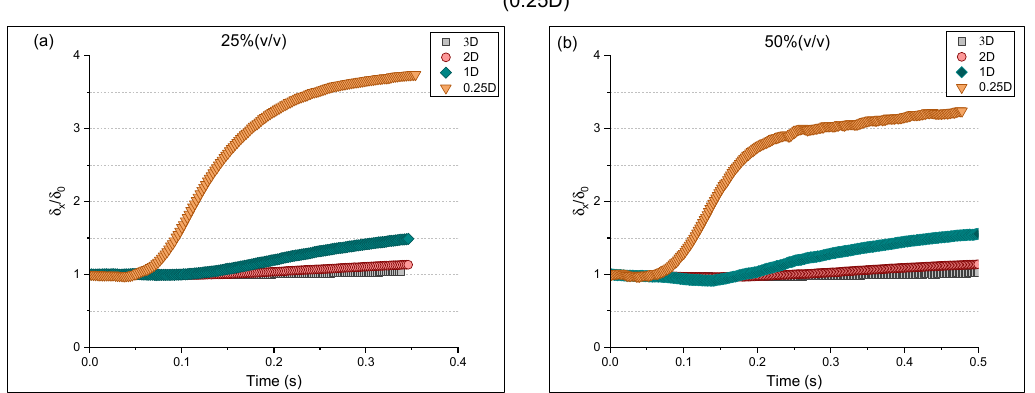
(cid:16) (cid:17) (cid:3083) (cid:3299) δ x (cid:4673) as a function of as a function of time δ 0 (cid:3083) (cid:3116)